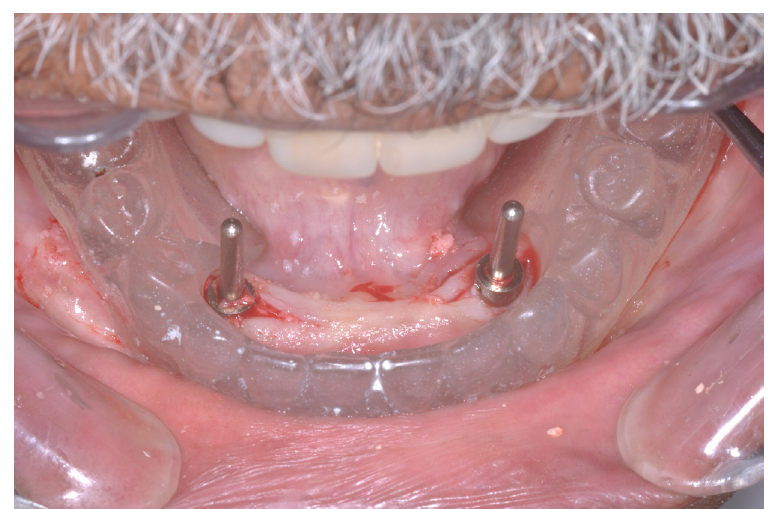
Figure 3- Implant positioner and surgical guide